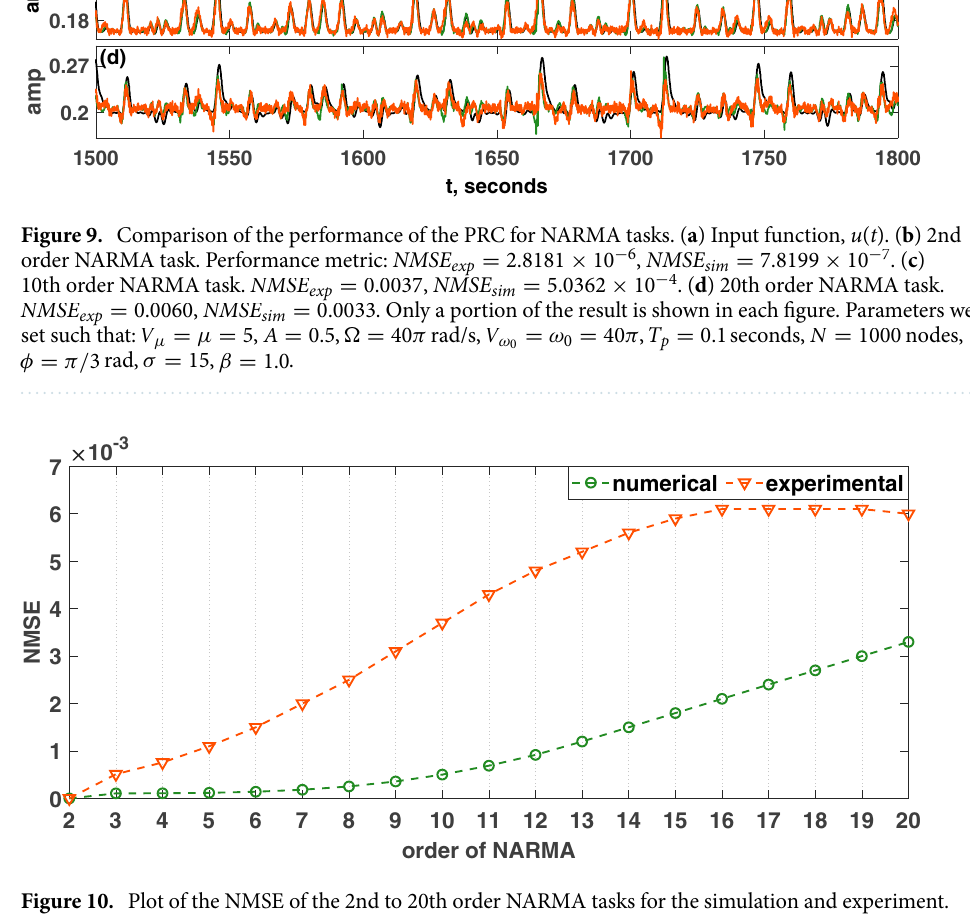
Figure 10. Plot of the NMSE of the 2nd to 20th order NARMA tasks for the simulation and experiment. Parameters were set such that: V µ = µ = 5 , A = 0.5 , � = 40 π rad/s, V ω 0 = ω 0 = 40 π , T p = 0.1 seconds, N = 1000 , φ = π/ 3 rad, σ = 15 , β = 1.0